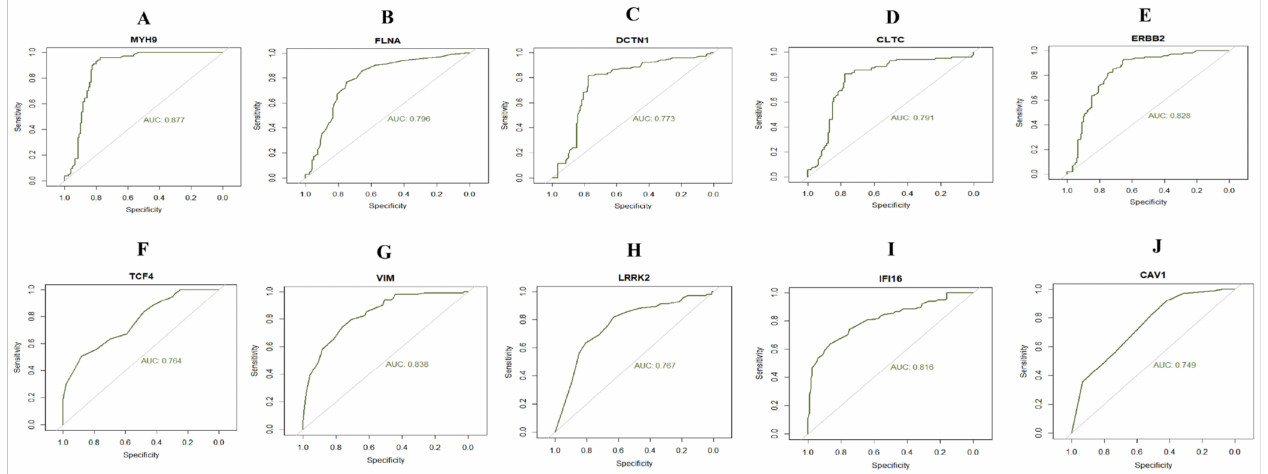
Figure 8. ROC curve analyses of hub genes. ( A ) MYH9 ( B ) FLNA ( C ) DCTN1 ( D ) CLTC ( E ) ERBB2 ( F ) TCF4 ( G ) VIM ( H ) LRRK2 ( I ) IFI16 ( J )